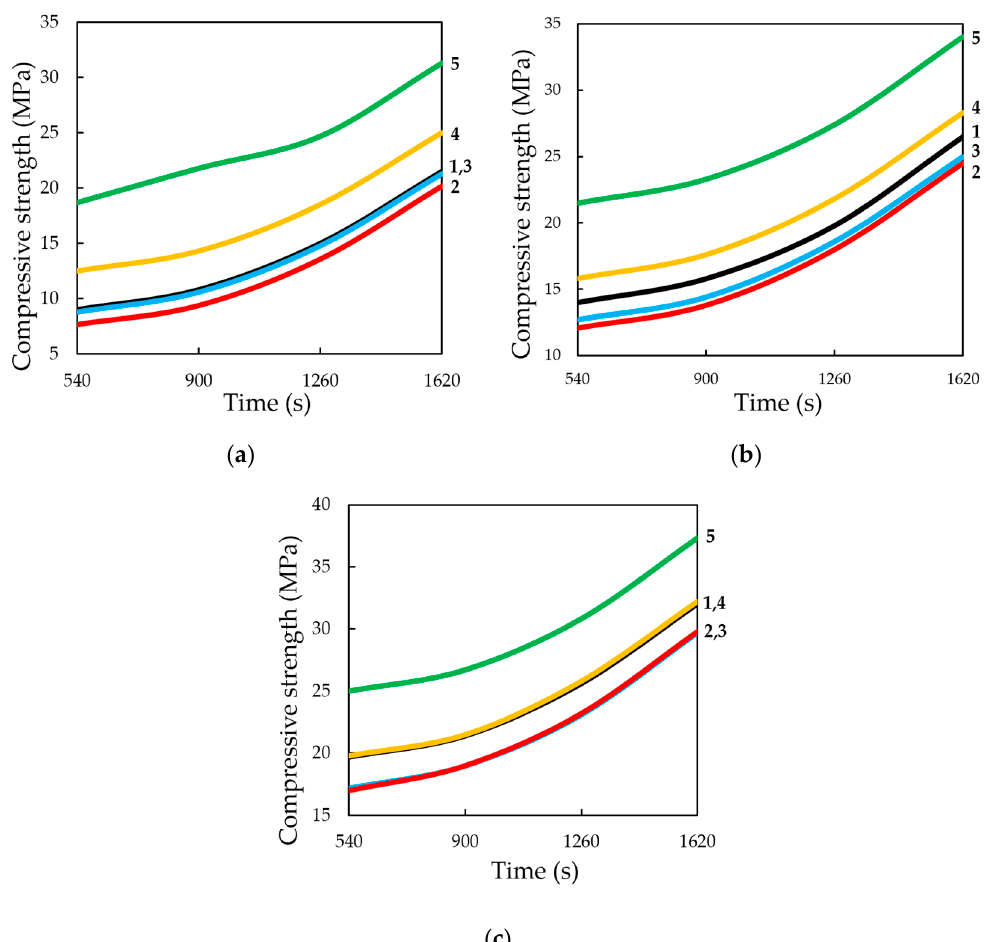
Figure 18. Variation of compressive strength limit of testing samples produced by semi-dry pressing at pressing pressure: ( a ) 15; ( b ) 25; ( c ) 35 MPa. Samples carbonated by the static method in gas and air environment with 40% concentration of CO 2 , depending on carbonation time and lime content in the raw mix, % wt.: 1 —5; 2 —10; 3 —15; 4 —20; 5